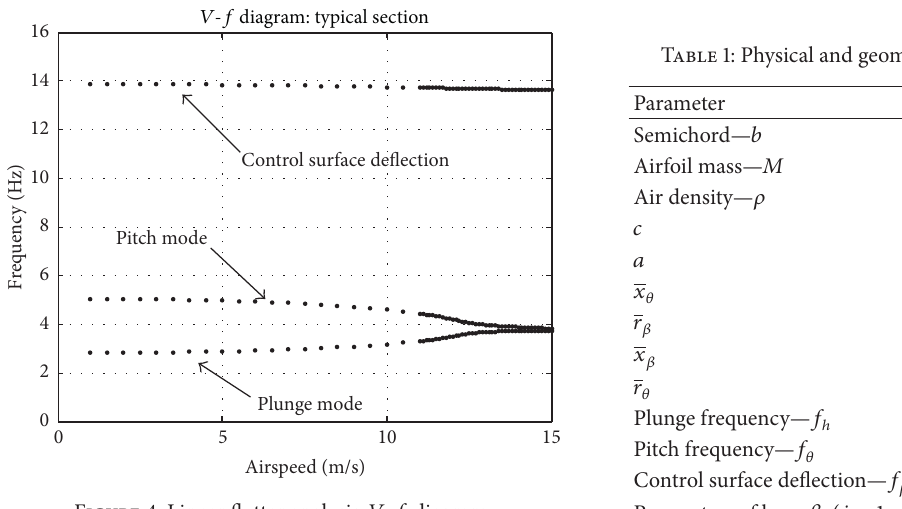
Figure 4: Linear flutter analysis: 𝑉 - 𝑓 diagram.